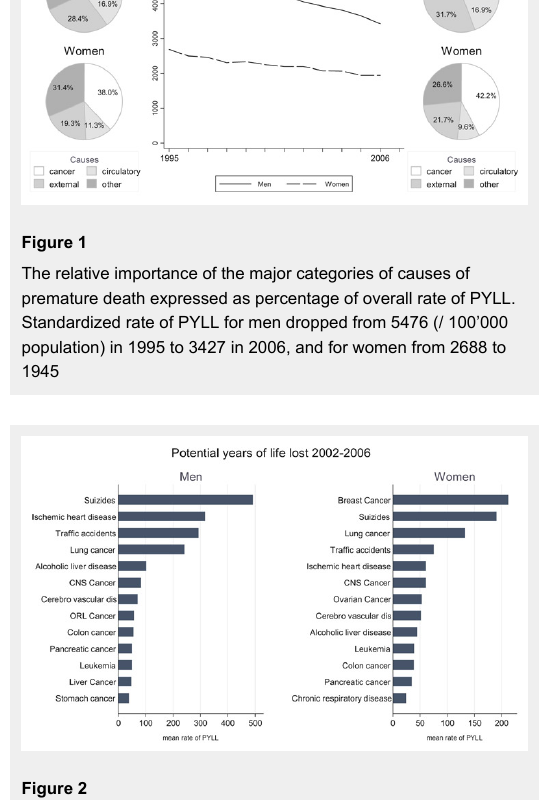
Leading causes of premature death based on 5-year mean of standardized rate of